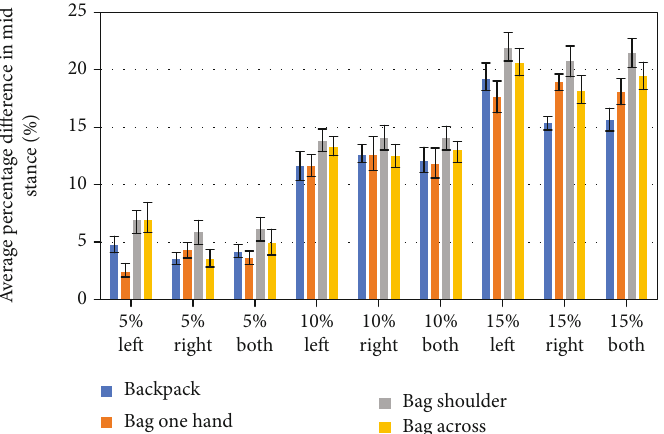
Figure 6: Maximal weight acceptance changes for the left, right, and average of both (left and right side) for di ff erent levels of additional load.